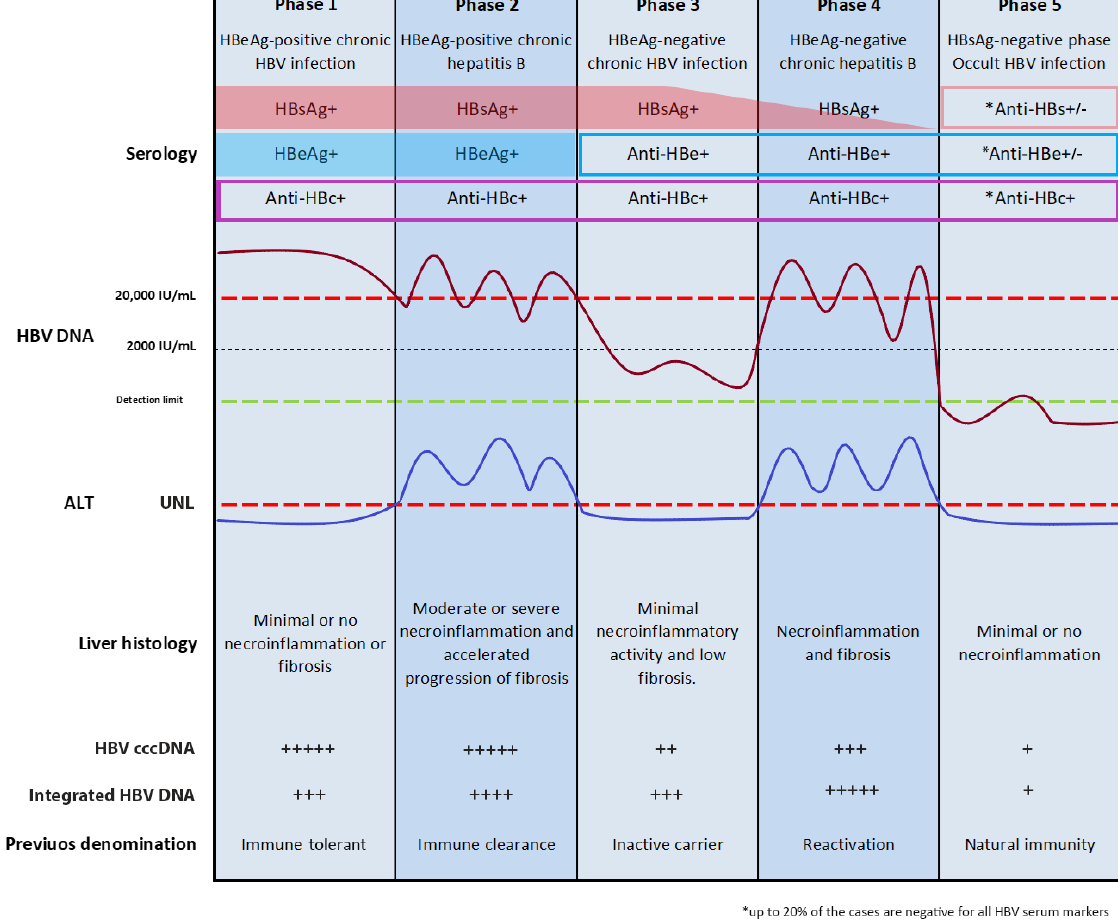
Figure 1. Natural history of hepatitis B. The natural history of chronic hepatitis B has been schematically divided into five clinical or virological phases (according to European Association for the Study of the Liver 2017 guidelines); +, rarely detected; ++, occasionally detected; +++, often detected; ++++, frequently detected; +++++, almost always detected. PgRNA, in addition to functioning as the mRNA for HBcAg and polymerase, is reverse transcribed within nucleocapsids into relaxed circular DNA (rcDNA). The nucleocapsids are then enveloped by the surface proteins and secreted from cells as a new infectious progeny virus or returned into the nucleus to replenish the intranuclear cccDNA minichromosome pool [29,30]. HBV DNA integration is not implicated in the production of new virions [29]. However, as a stable intrahepatic source of HBx transcriptional transactivator and of immunomodulatory HBsAg, it might favor viral replication, immune tolerance, and viral persistence [12,36–38]. The double-stranded linear DNA (dslDNA) is likely the primary substrate for HBV integration (Figure 2). It is an aberrant byproduct of virus DNA synthesis due to the in situ priming of viral plus- strand DNA [30,39]. Analogously to HBV rcDNA, the dslDNA can be either secreted from hepatocytes as new virions or recycled into the nucleus. Once the dslDNA is delivered into the nucleus, either after the de novo secondary infection of hepatocytes or intracellular nucleocapsid recycling, it may integrate at the sites of double-stranded DNA breaks of the host cell genome by nonhomologous end joining (NHEJ) or microhomology- mediated end joining (MMEJ) [40–42] (Figure 2). The sequence of the dslDNA implies that the integrated HBV DNA can, at most, transcribe one intact preS-S HBV mRNA, which may lead to the synthesis of surface proteins, which include HBsAg [12,37,38,43]. Preliminary data obtained by targeted long-read sequencing (Pacific Biosciences Sequel II